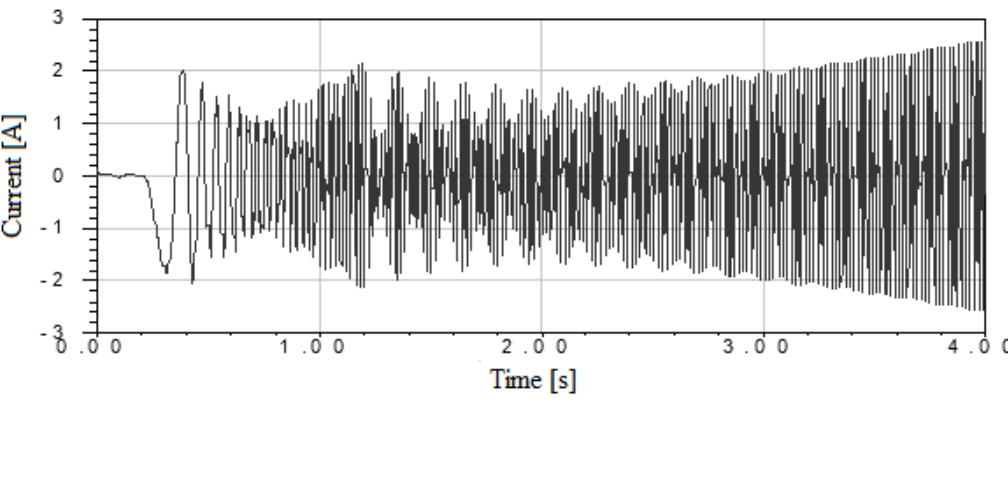
Figure 3. The characteristic of current during starting and the motor